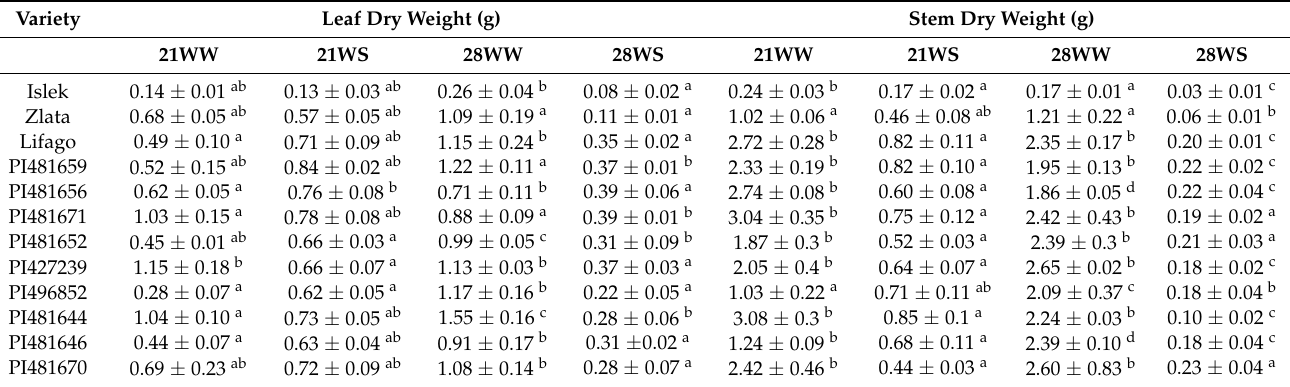
Table 2. Leaf and stem dry weight of F. tataricum varieties subjected to two temperatures (21 ◦ C vs. 28 ◦ C) and water supply conditions (well-watered (WW) vs. water-stressed (WS)). Leaf Dry Weight (g) Stem Dry Weight